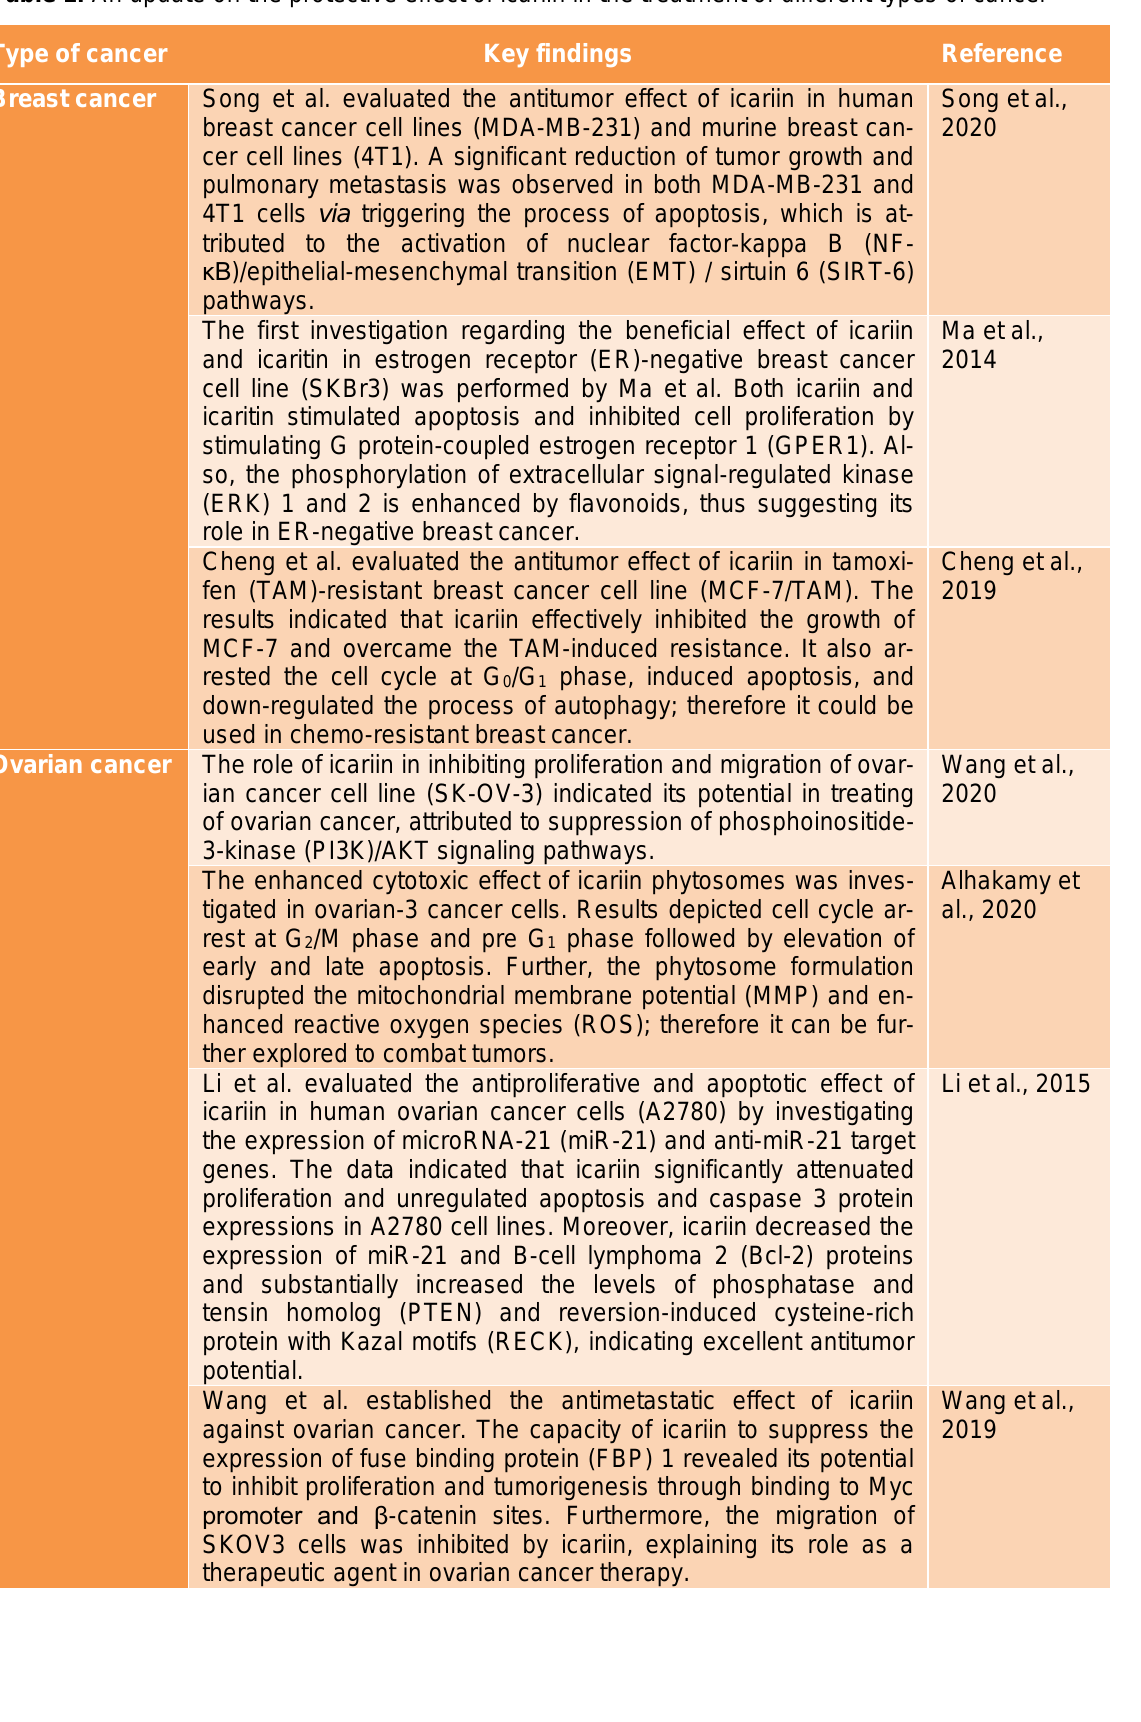
Table 1: An update on the protective effect of icariin in the treatment of different types of cancer Type of